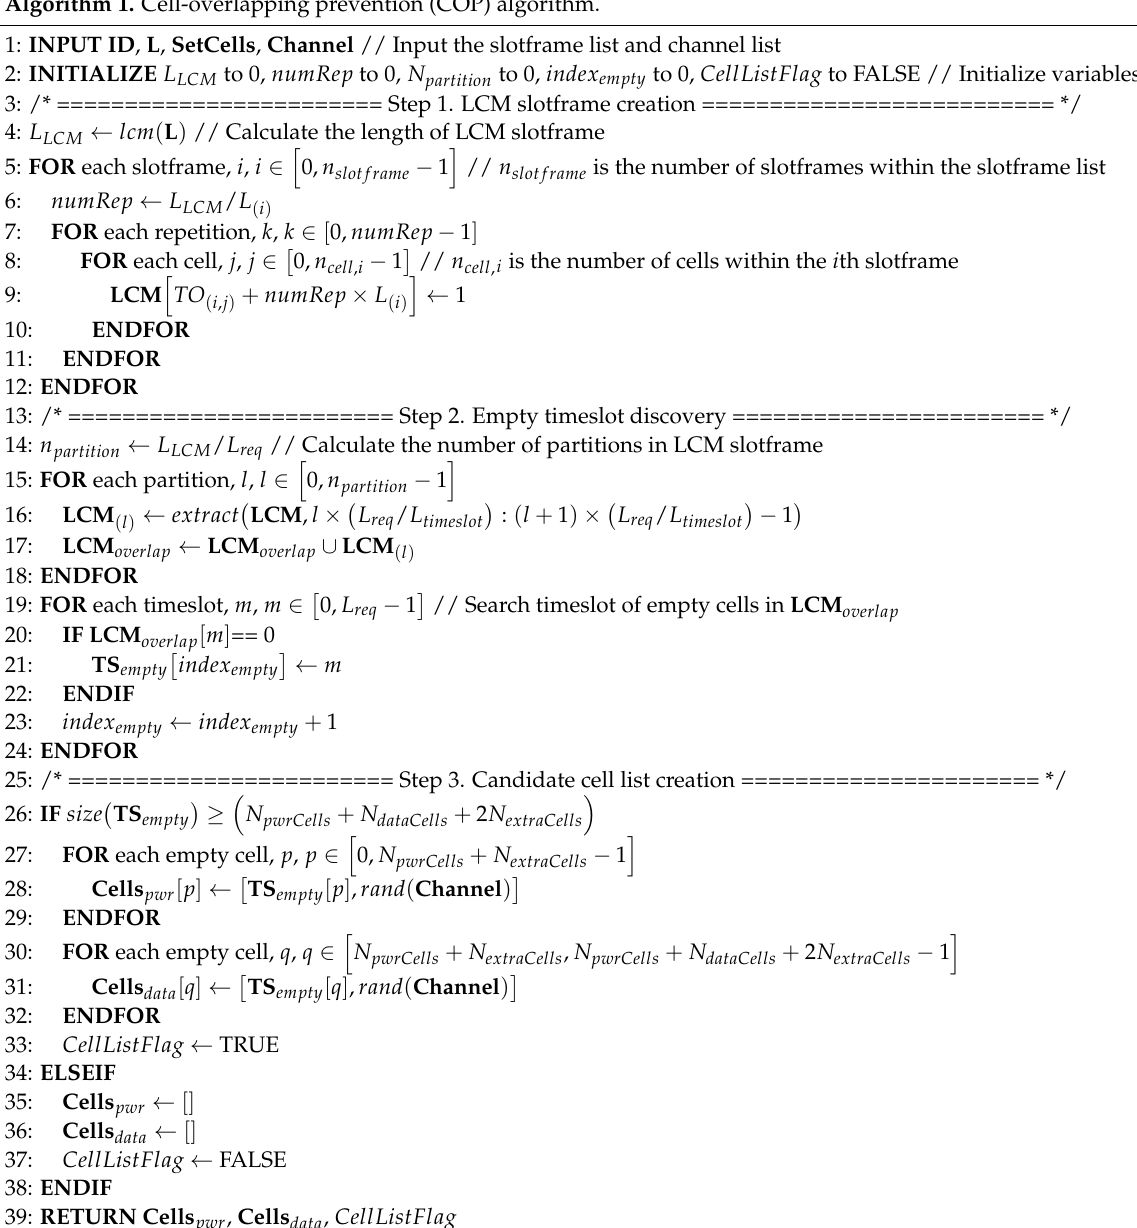
Algorithm 1. Cell-overlapping prevention (COP)